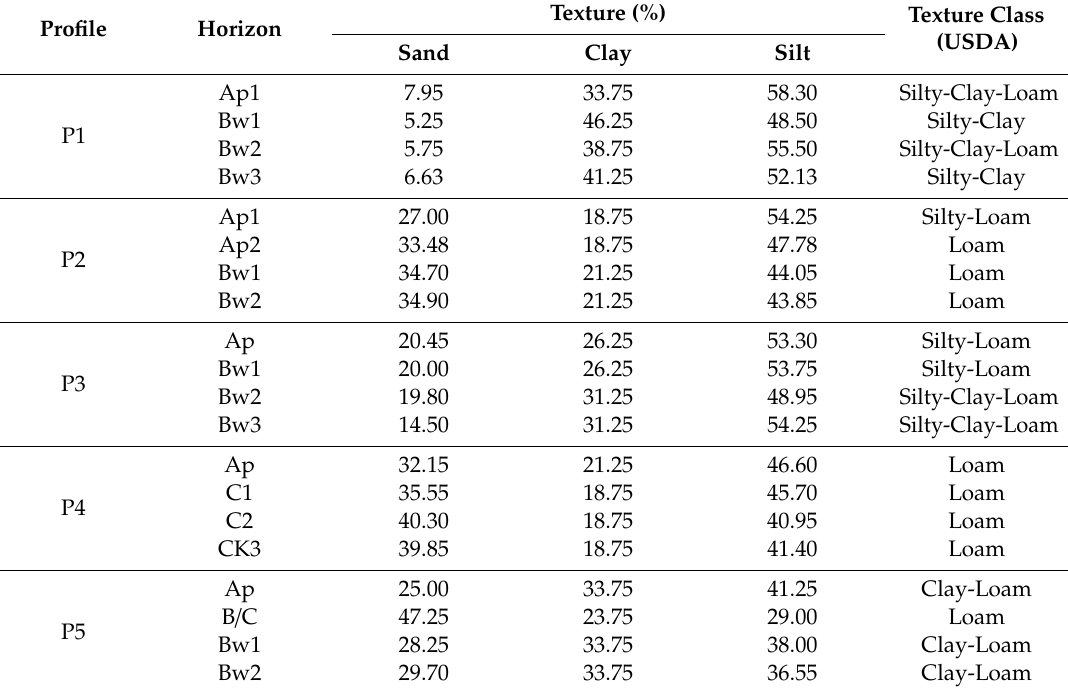
Table 1. Pedological descriptions and textural data for each soil profile.